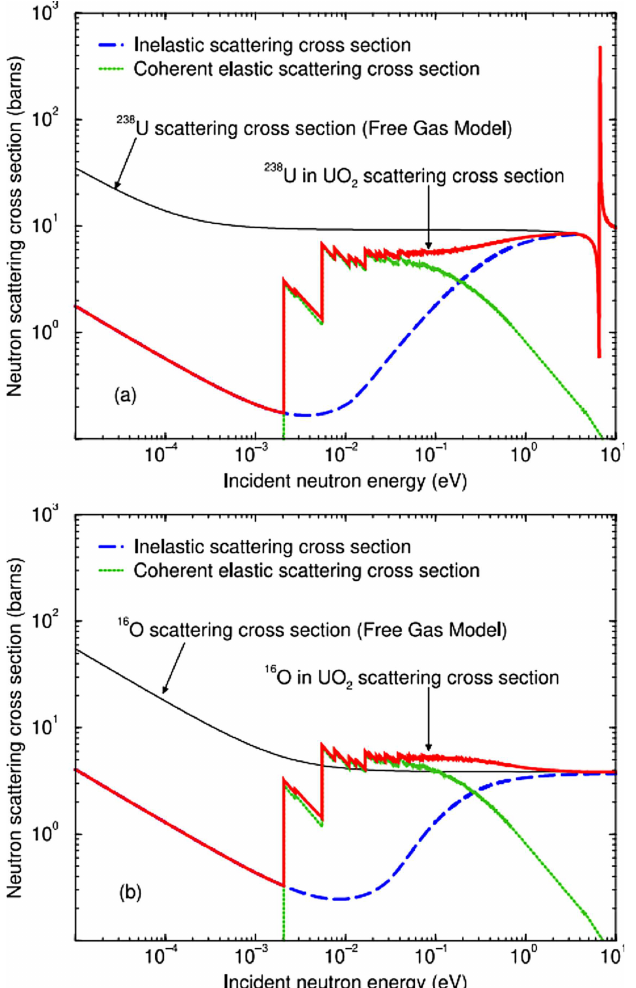
Fig. 2. Neutron elastic scattering cross sections of 238 U and 16 O in UO 2 reconstructed with the evaluated nuclear data files available in the test library JEFF-4T1.